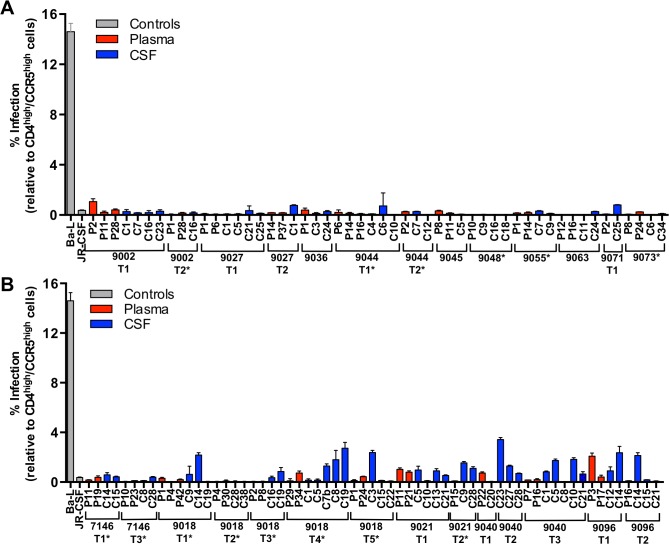
All viruses required high levels of CD4 for efficient entry, indicative of primarily being selected for replication in CD4+ T cells.Single-cycle infection of HIV-1 Env-pseudotyped reporter viruses on CD4lowCCR5high 293-Affinofile cells [28]. Receptor expression was measured as follows: CD4low = 972 receptors/cell, CD4high = 72,041 receptors/cell, CCR5high = 15,636 receptors/cell. The data are averaged from triplicate wells for each of 2 to 3 env clones that were generated per indicated amplicon. Amplicons were selected for cloning to represent different portions of the phylogenetic tree. Subjects with no evidence of CNS compartmentalization (i.e. equilibrated) are shown in panel (A); and subjects with CNS compartmentalization at one or more time points are in panel (B). Longitudinal time points are indicated (T1, T2, T3, etc.) and samples with marked pleocytosis are noted (*).